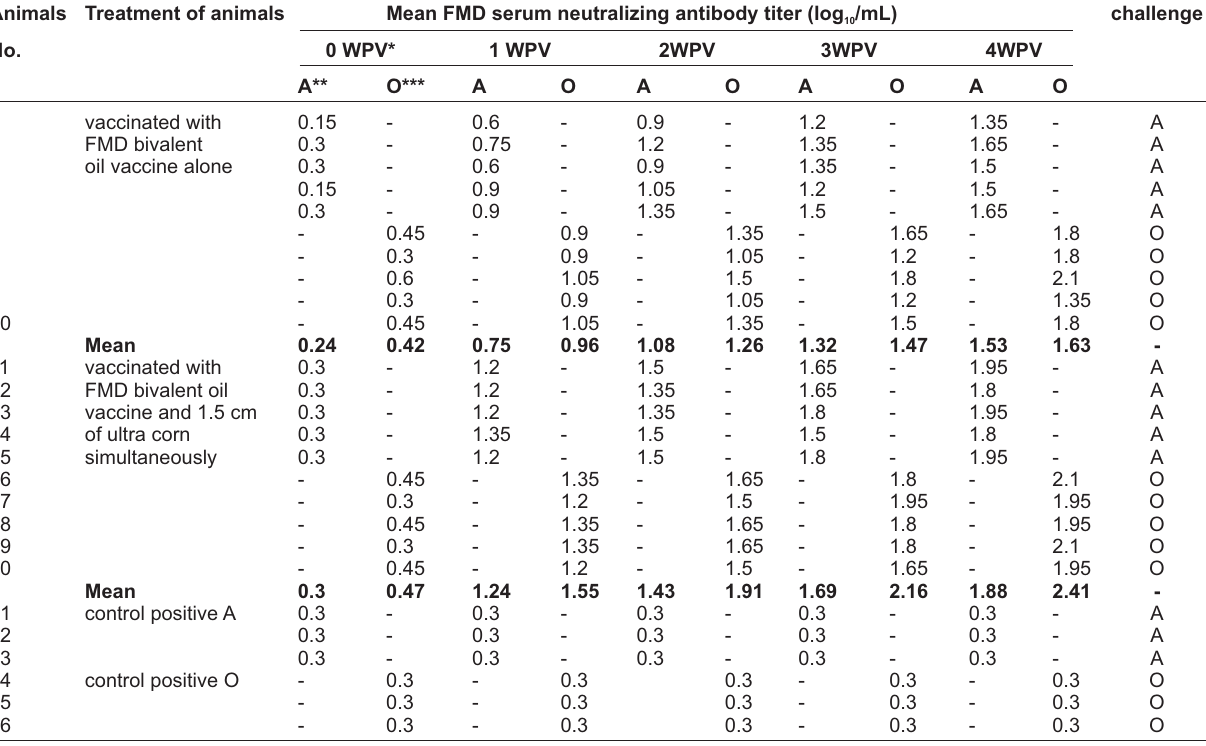
Table-3. Mean FMD serum neutralizing antibody titers in calves vaccinated with bivalent FMD and 1.5 mL ultra-corn/100kg body weight simultaneously (Locality B) Animals Treatment of